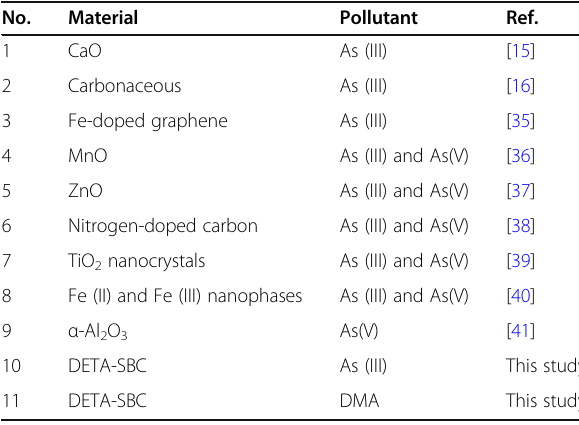
Table 4 DFT simulates the adsorption mechanism of arsenic adsorbed on the surface of the different materials No. Material